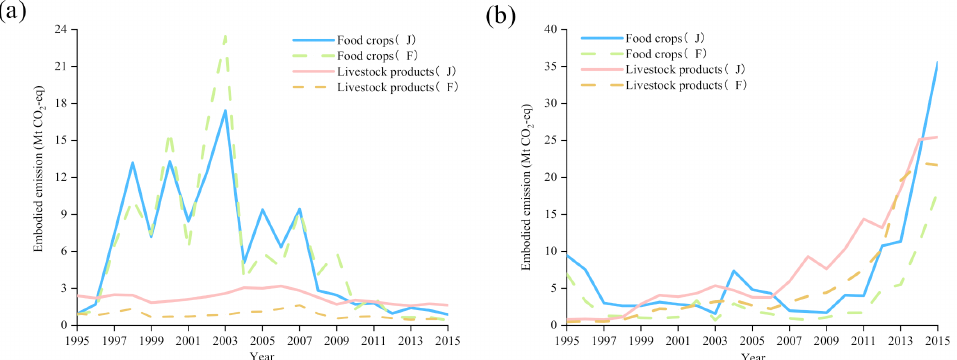
Figure 9. ( a ) GHG emissions embodied in China’s export of main agricultural products under different CEFs; ( b ) GHG emissions embodied in China’s import of main agricultural products under different CEFs. Note: F represents the results based on the CEFs of FAO and J represents the result based on the CEFs of Hawkins et al.